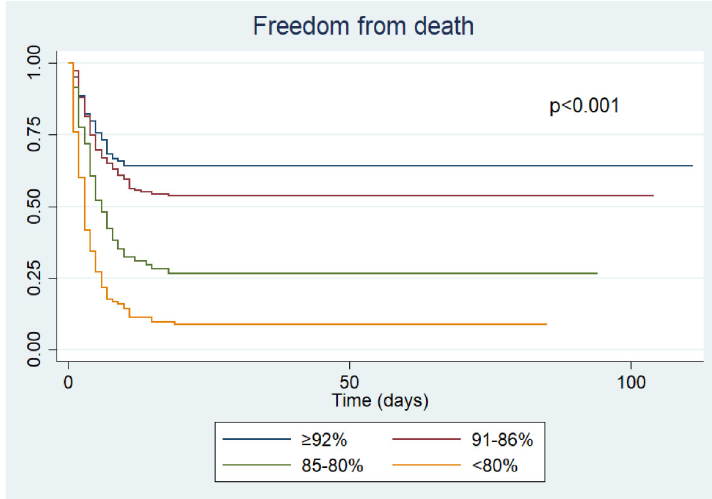
Figure 1. Survival analysis by oxygen saturation level at hospital admission.